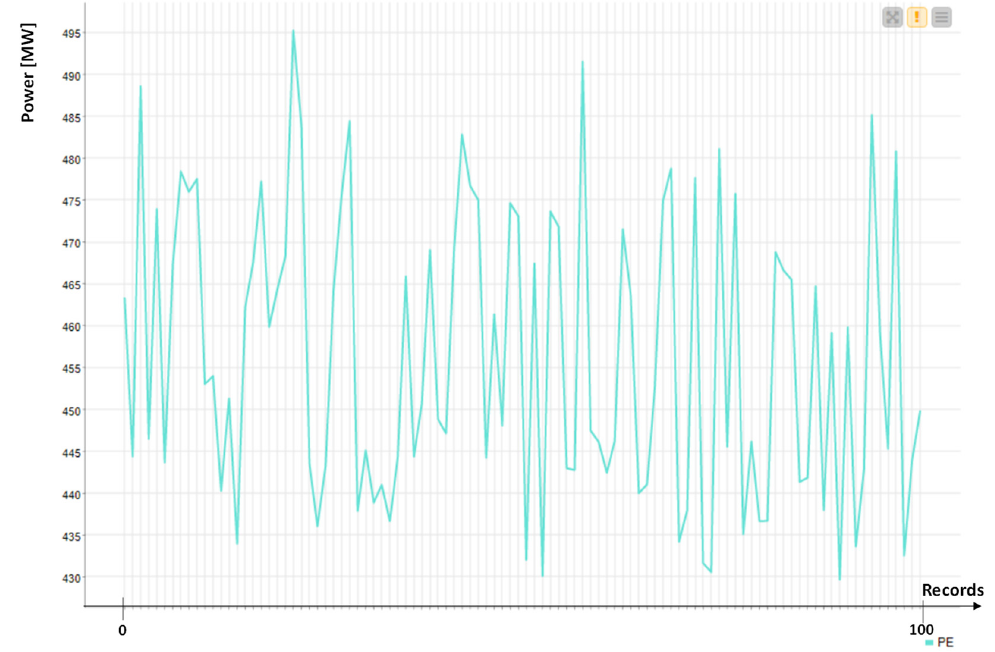
Figure 5. Produced energy power: first 100 records of the dataset [25].